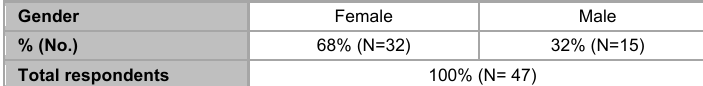
Distribution of respondents according to